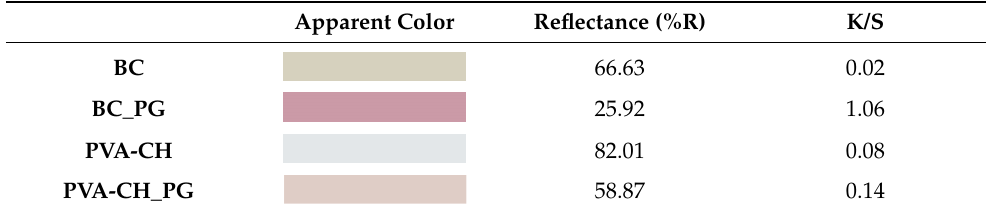
Table 2. Apparent color, reflectance, and color strength (K/S value) of each layer before and after functionalization with PG.